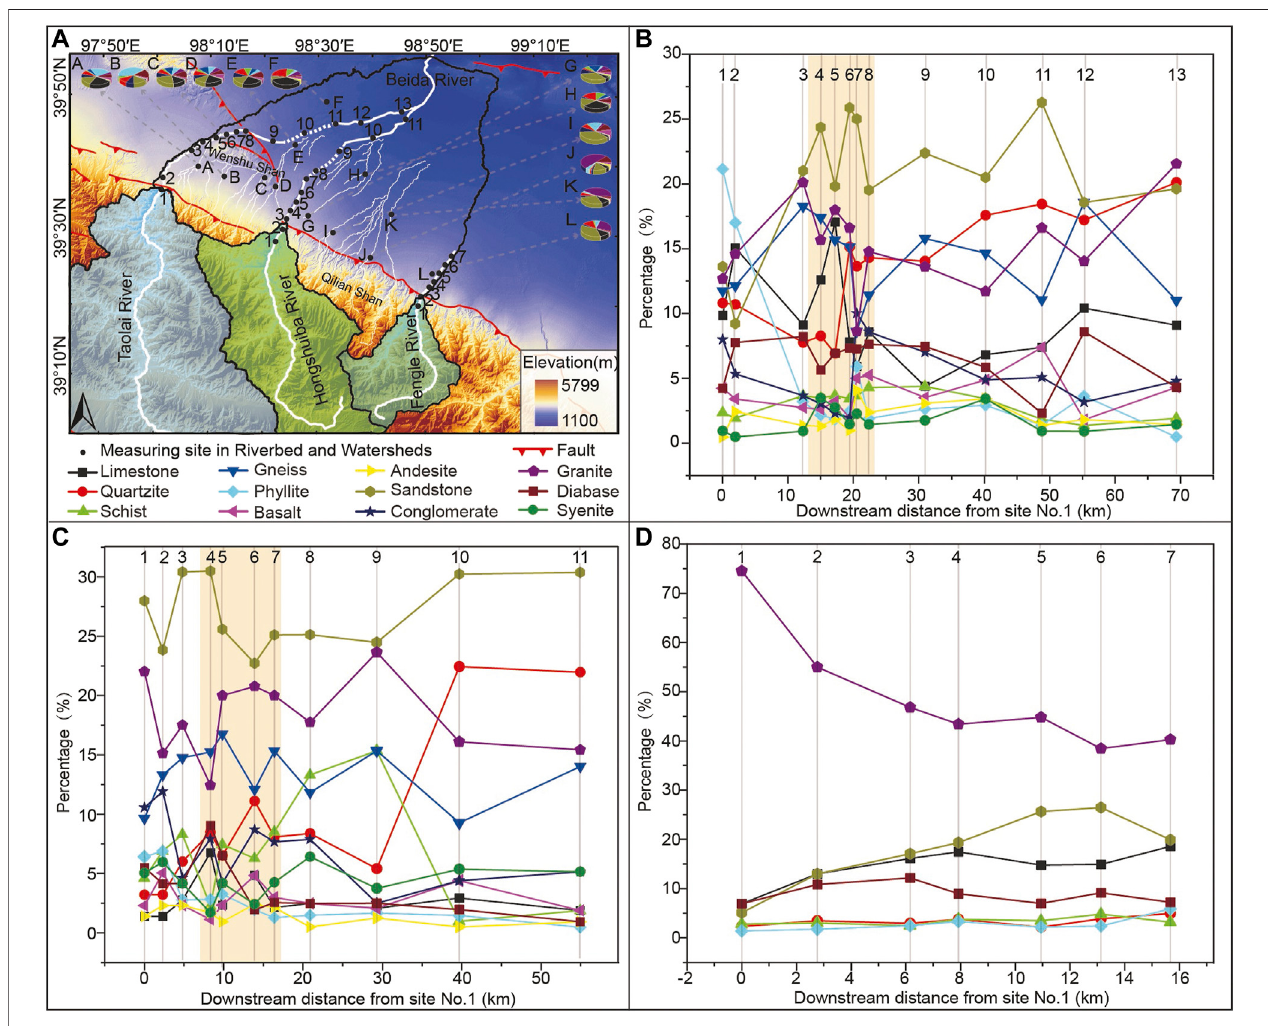
FIGURE 3 | Statistical data on bedload gravel lithology. (A) The Beida River catchment. All sampling sites and correspondent lithological composition of bedload gravels have been numbered in downstream sequence along its three tributaries, the Taolai, Hongshuiba, and Fengle Rivers. Furthermore, a total of 12 samples taken from the watersheds between these tributaries has been marked from A to L. Fine white lines indicate watershed gullies. (B) , (C) and (D) Downstream variations in lithological proportion ofthe bedload gravels along the Taolai Hongshuiba, and Fengle Rivers, respectively. All the sampling sites are marked by number sequence which is coincident with (A) , the shaded area in (B) and (C) indicates that the rivers fl ow through the Wenshu Shan.